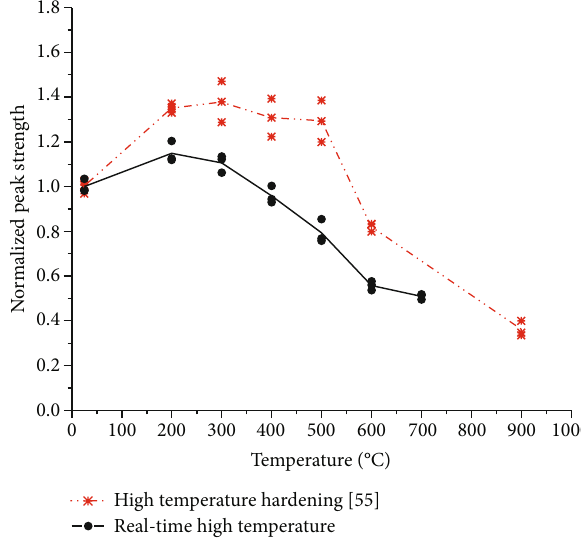
Figure 7: Normalized peak strength versus test temperature curves for granite at real-time high temperature and granite after high- temperature